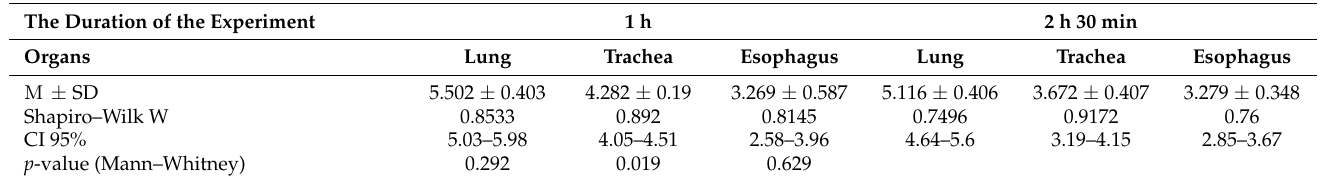
Table 2. Concentrations of bacteriophage MS2 (Log10 PFU/mL) in lungs, esophagus, and trachea of mice post 1 and 2.5 h of the inoculation